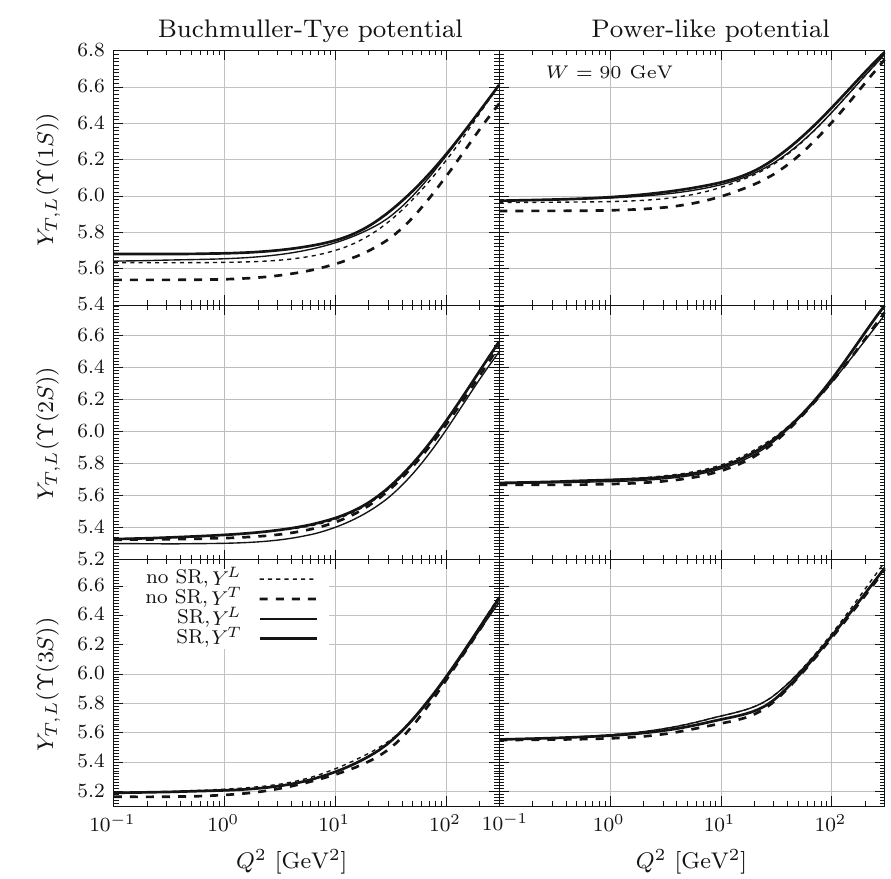
Fig. 2 The Q 2 dependence of the scale parameters Y T and Y L defining the magnitude of the scanning radius, Eq. (1.1), for production of T and L polarized ϒ( 1 S ) (upper boxes), ϒ (cid:2) ( 2 S ) (middle boxes) and ϒ (cid:2)(cid:2) ( 3 S ) (lower boxes) vector mesons. The solid and dashed curves represent the values of Y T and Y L with and without effects of the Melosh spin rotation, respectively. The thin and thick curves corresponds to production of L and T polarized vector mesons, respectively. The calculations have been performed with the vector meson wave function using the realistic Buchmüller–Tye [31] (left boxes) and power-low [32] (right boxes)